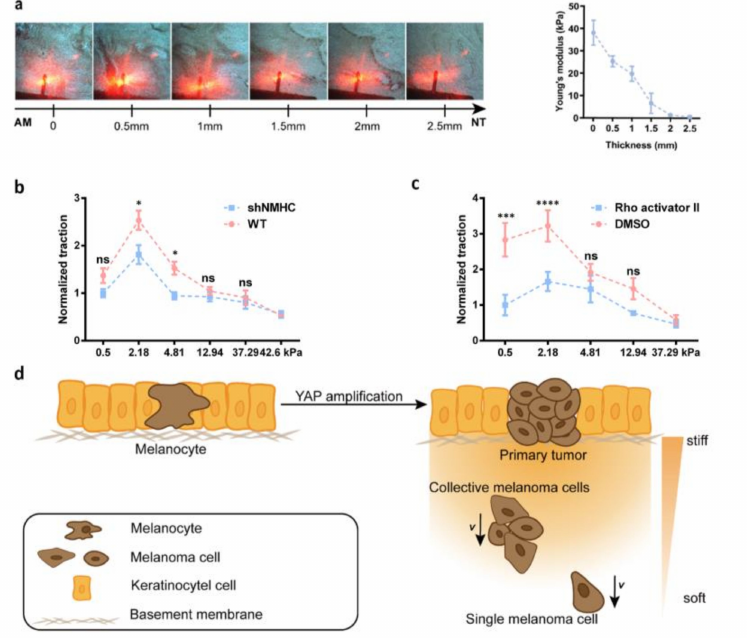
Figure 4. Acral melanoma provides a perfect mechanical environment for tumor invasion though negative durotaxis. ( a ) Left: Images shows stiffness measurement using atomic force microscopy (AFM), red/yellow color is laser of AFM, the shadow in the center of red/yellow color is the cantilever of AFM, AM: acral melanoma, NT: normal tissue; Right: Quantification of acral melanoma stiffness every 0.5mm, error bar is SD, *, p < 0.05, by one-way ANOVA, ns, none significant. ( b )